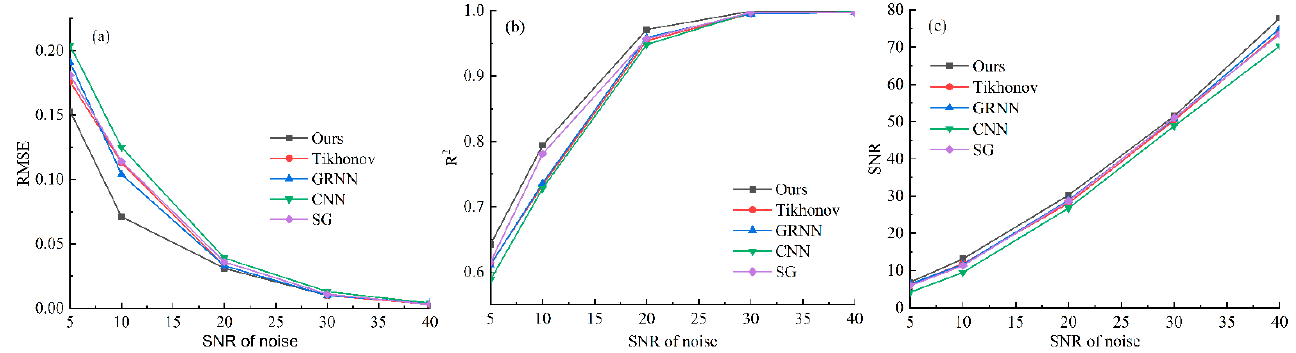
Figure 5. The quantitative analysis results of the synthesized spectrum. ( a ) The score of RMSE, ( b ) The score of R 2 . ( c ) The score of SNR